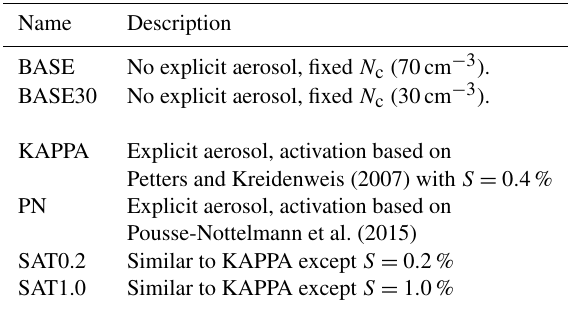
Table 2. Overview and description of the different simulations per- formed in this